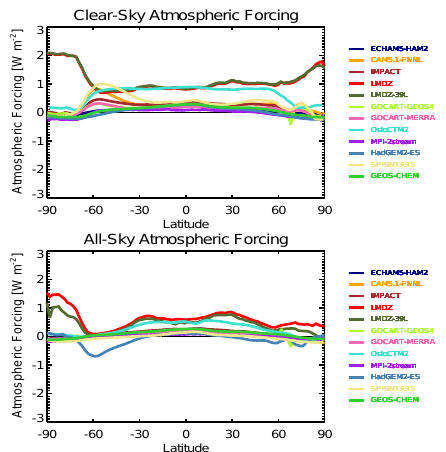
Fig. A4. Annual zonal-mean short-wave all-sky atmospheric radiative forcing (absorption) between experiments with AOD=0.2 and AOD=0.0 distributed over the lowest two kilometers, holding SSA=1.0 and ANG=1.0 constant (FIX2-FIX0).